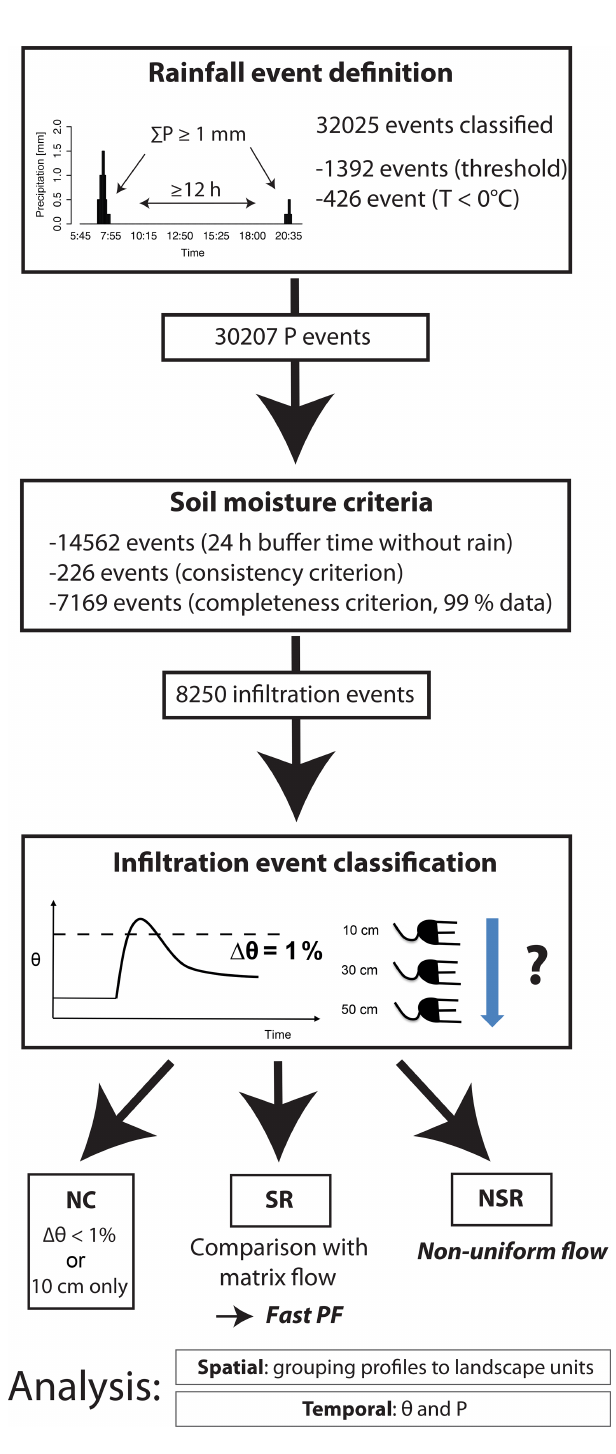
Figure 2. Workflow for the estimation of spatial and temporal PF occurrence from soil moisture data with the number of included and excluded events. Event numbers refer to the sum of the events on a profile base (since this number is the resulting number of data points used for each analysis).